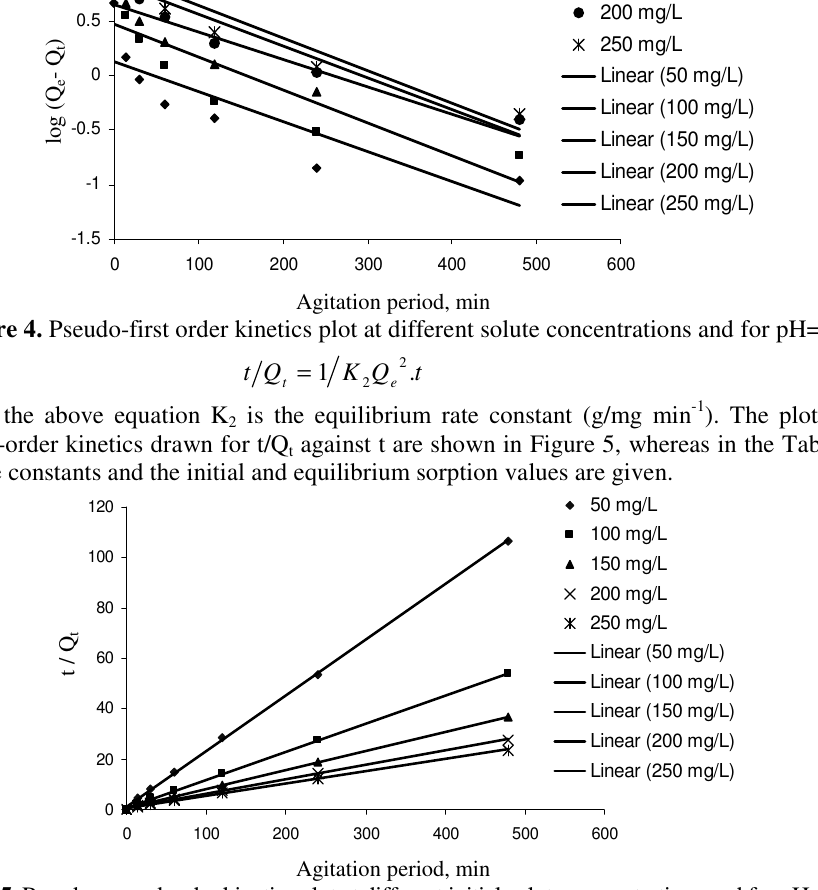
Figure 5 . Pseudo-second order kinetics plot at different initial solute concentrations and for pH=8. Good fits were obtained for all the initial concentrations. The equilibrium adsorption Q values obtained from the plots were close to the experimental values. The correlation coefficients were very near to one, the highest value being equal to 0.99990. All the facts suggested that the experimental sorption data approximated the second-order kinetic model very